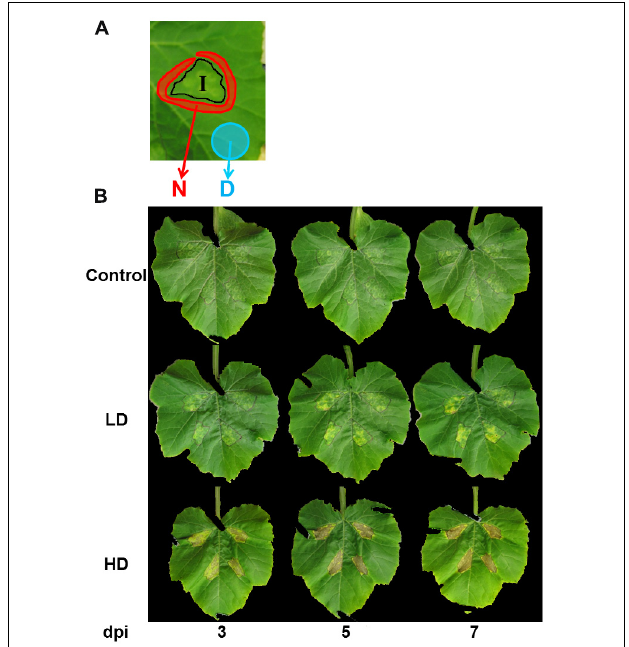
FIGURE 1 | (A) Areas defined for image analysis of mock and bacteria-infiltrated zucchini leaves: I is the infiltrated area, accurately outlined using a marker pen at the moment of the infiltration; N is the neighboring area; and D are distal regions away from the I area. (B) Evolution of symptoms of zucchini leaves inoculated with D. dadantii at LD or